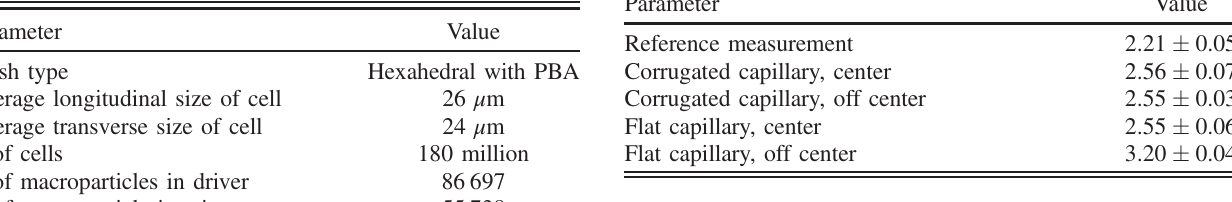
TABLE II. Mesh and macroparticle parameters for second simulation setup. PBA — perfect boundary approximation.